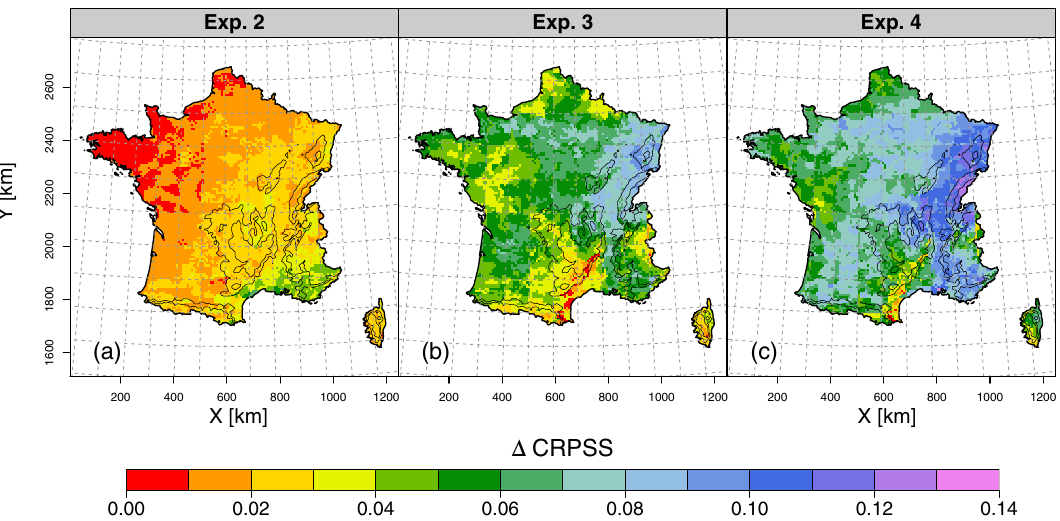
Figure 7. Gain in CRPSS for different prediction experiments (see Sect. 4.2 for details) compared to the performance of AM 25 . (a) Exp. 2: only the precipitation occurrence probability is updated (when possible); (b) Exp. 3: only the precipitation amount is updated (when possible); (c) Exp. 4: both occurrence probability and precipitation amount are updated (when